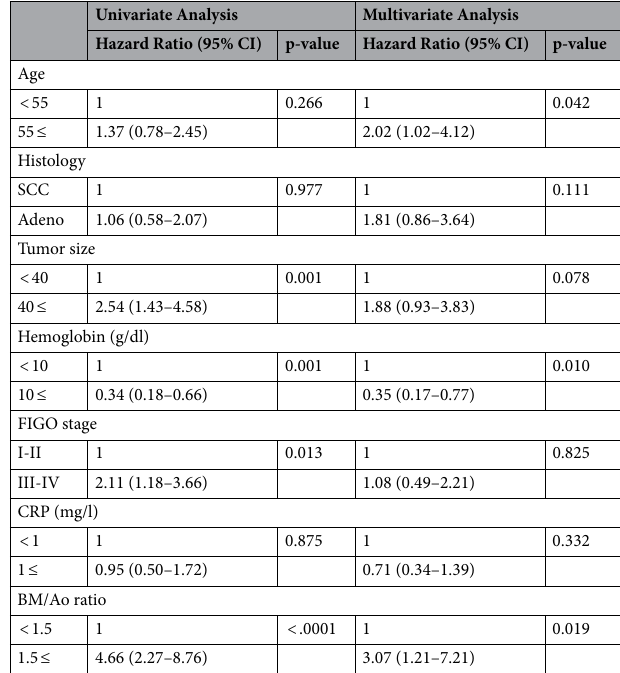
Table 2. Univariate and multivariate analyses for PFS in cervical cancer patients. CI, confidence interval; SCC, squamous cell carcinoma; Adeno, adenocarcinoma; FIGO, International Federation of Gynecology and Obstetrics;CRP, C-reactive protein; BM, Bone marrow; Ao, Aorta. P-values were calculated using the two-sided Wald test in the Cox proportional hazard